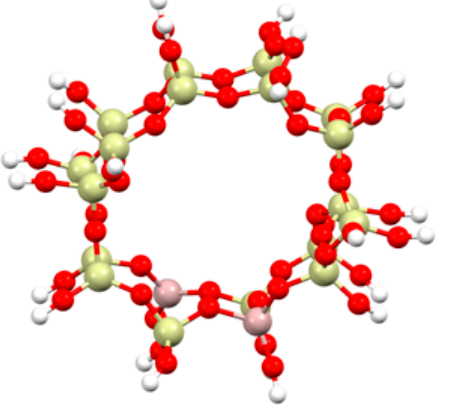
Figure 10. Structure used for the ZSM-5 zeolite (Al 2 Si 18 O 53 H 26 ) calculations.